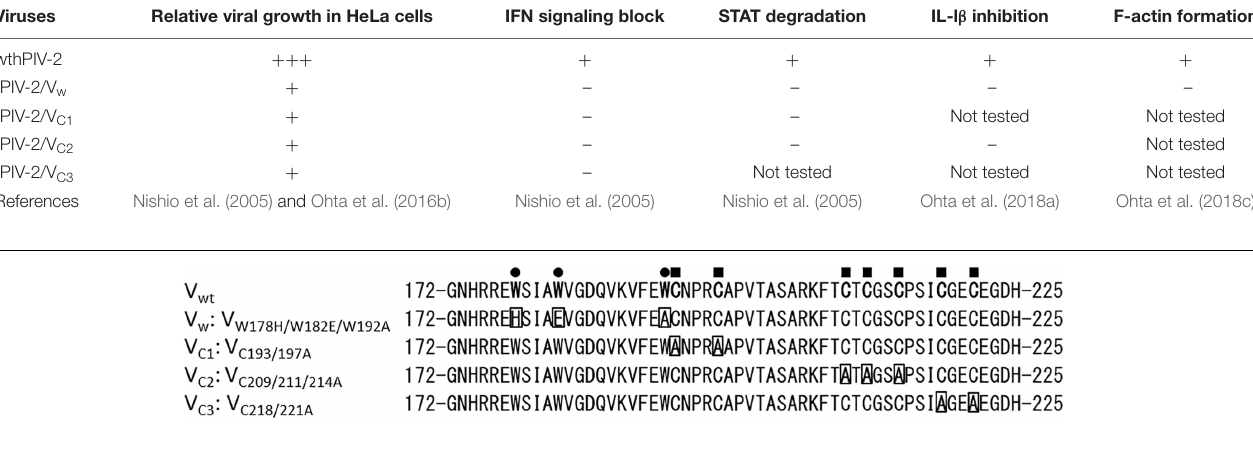
FIGURE 1 | Amino acid sequences of the V-specific region of hPIV-2 V proteins. Trp and Cys residues are marked with filled circles and filled squares, respectively. Trp- and Cys-mutated V proteins used in this study are also